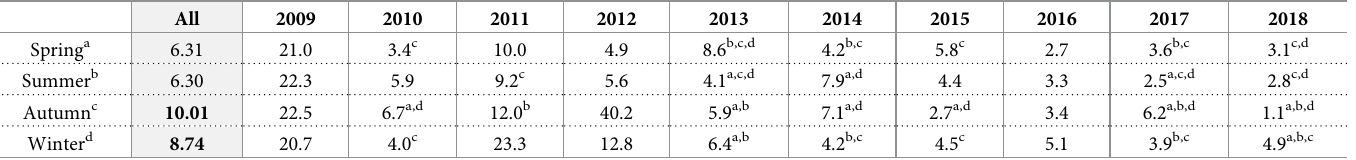
a,b,c,d indicates the significance of the difference between the corresponding (indexed) seasons.